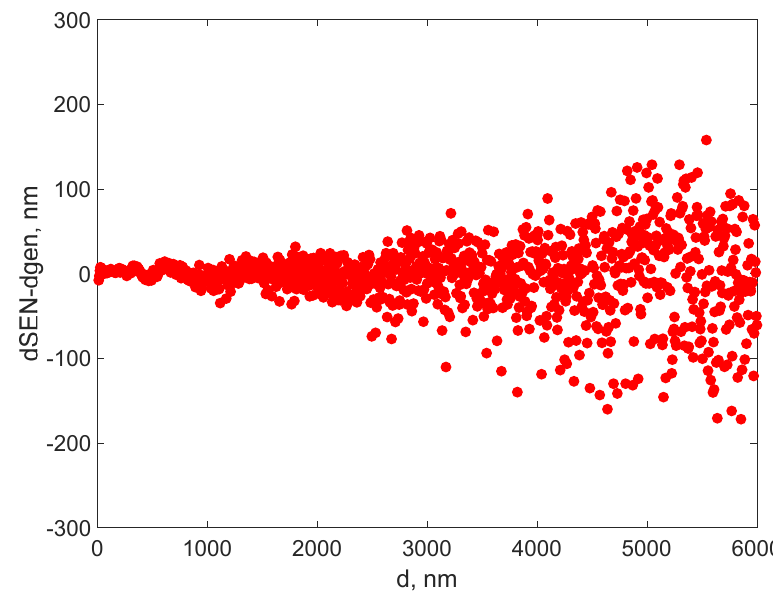
Figure 6. The absolute errors in assessing the d SEN diameters